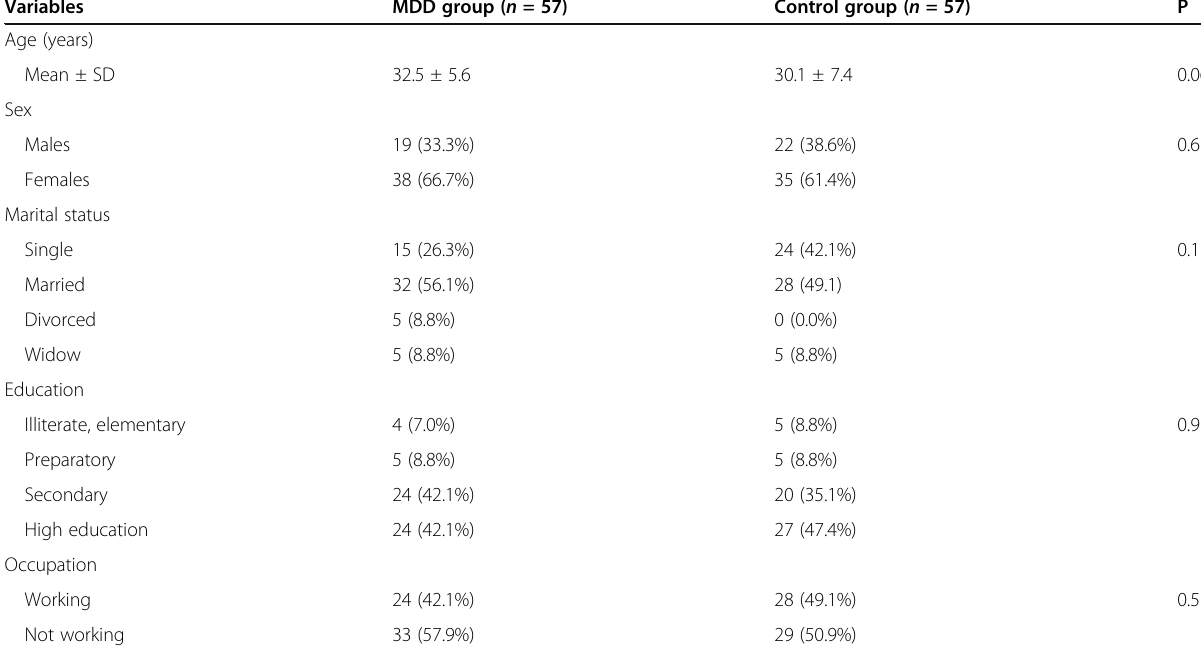
Table 1 Demographic characteristics of the studied groups